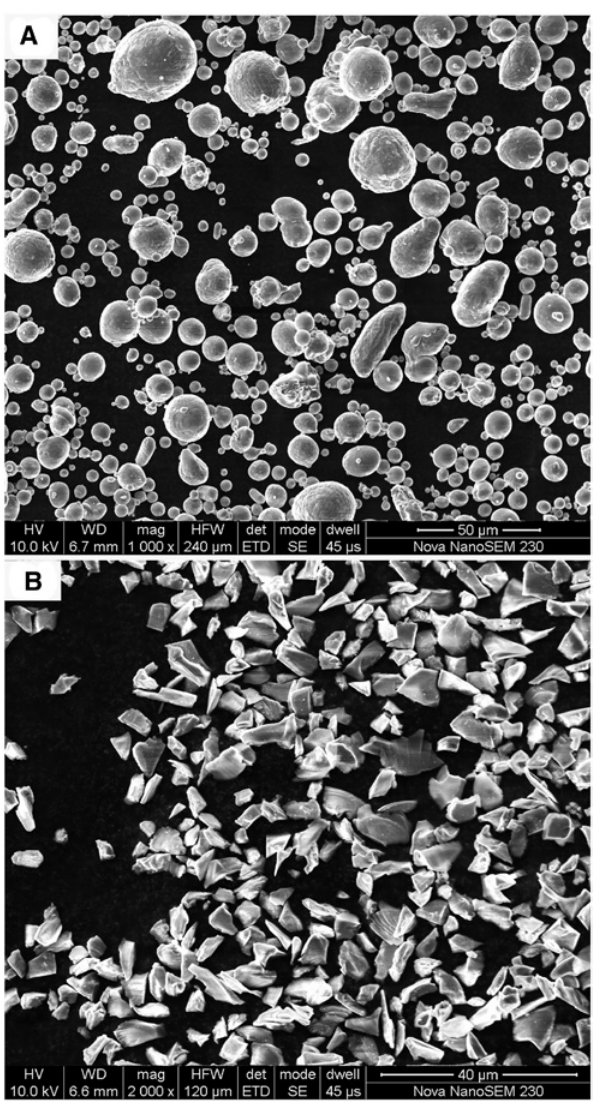
Figure 1: SEM graphs of (A) pre-alloying powder and (B) SiC